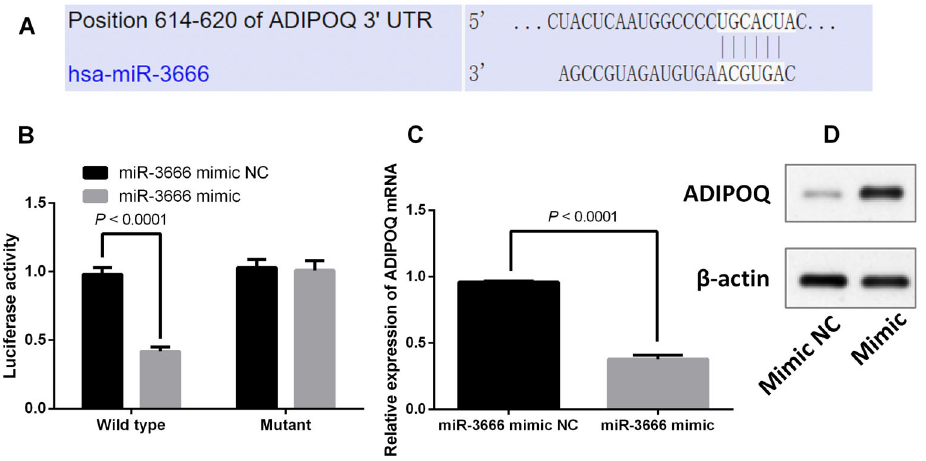
Figure 3. Adiponectin (ADIPOQ) is a direct target of miR-3666 in pancreatic b -cells. A , Interaction sites between miR-3666 and 3 0 UTR of ADIPOQ. B , INS-1 cells were co-transfected with fi re fl y luciferase constructs containing the ADIPOQ wild type or mutant 3 0 UTR and miR-3666 mimic (miR-mimic) or mimic-normal control (NC). Luciferase activity was measured 48 h after transfection. C and D , mRNA levels and protein expression of ADIPOQ after transfection with miR-mimic or mimic-NC. Data are reported as means ± SE (n=3) and were compared with the t